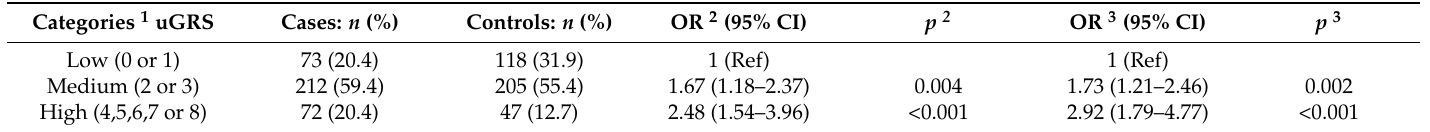
Table 3. Categories of the unweighted genetic risk score (uGRS) in POAG cases and controls and associations with POAG